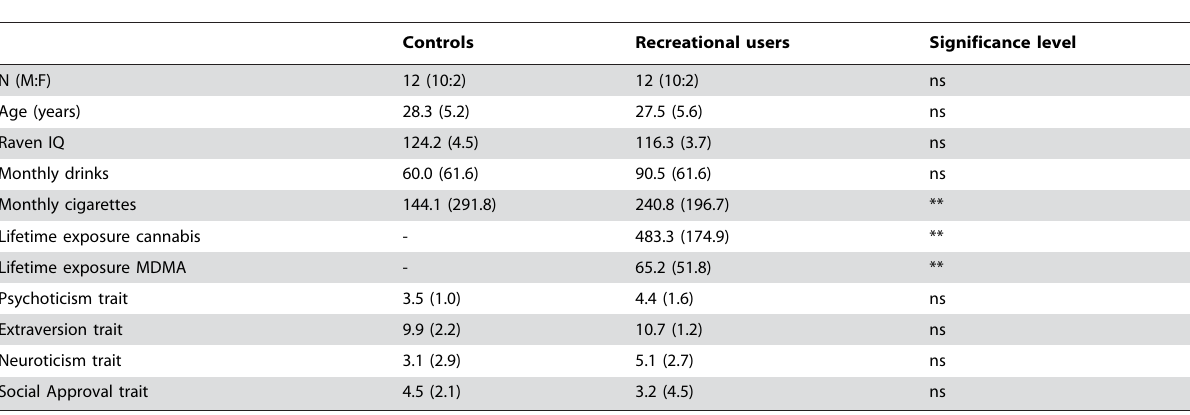
Table 1. Demographic characteristics, EPQ-R scores, and use of other recreational drugs.